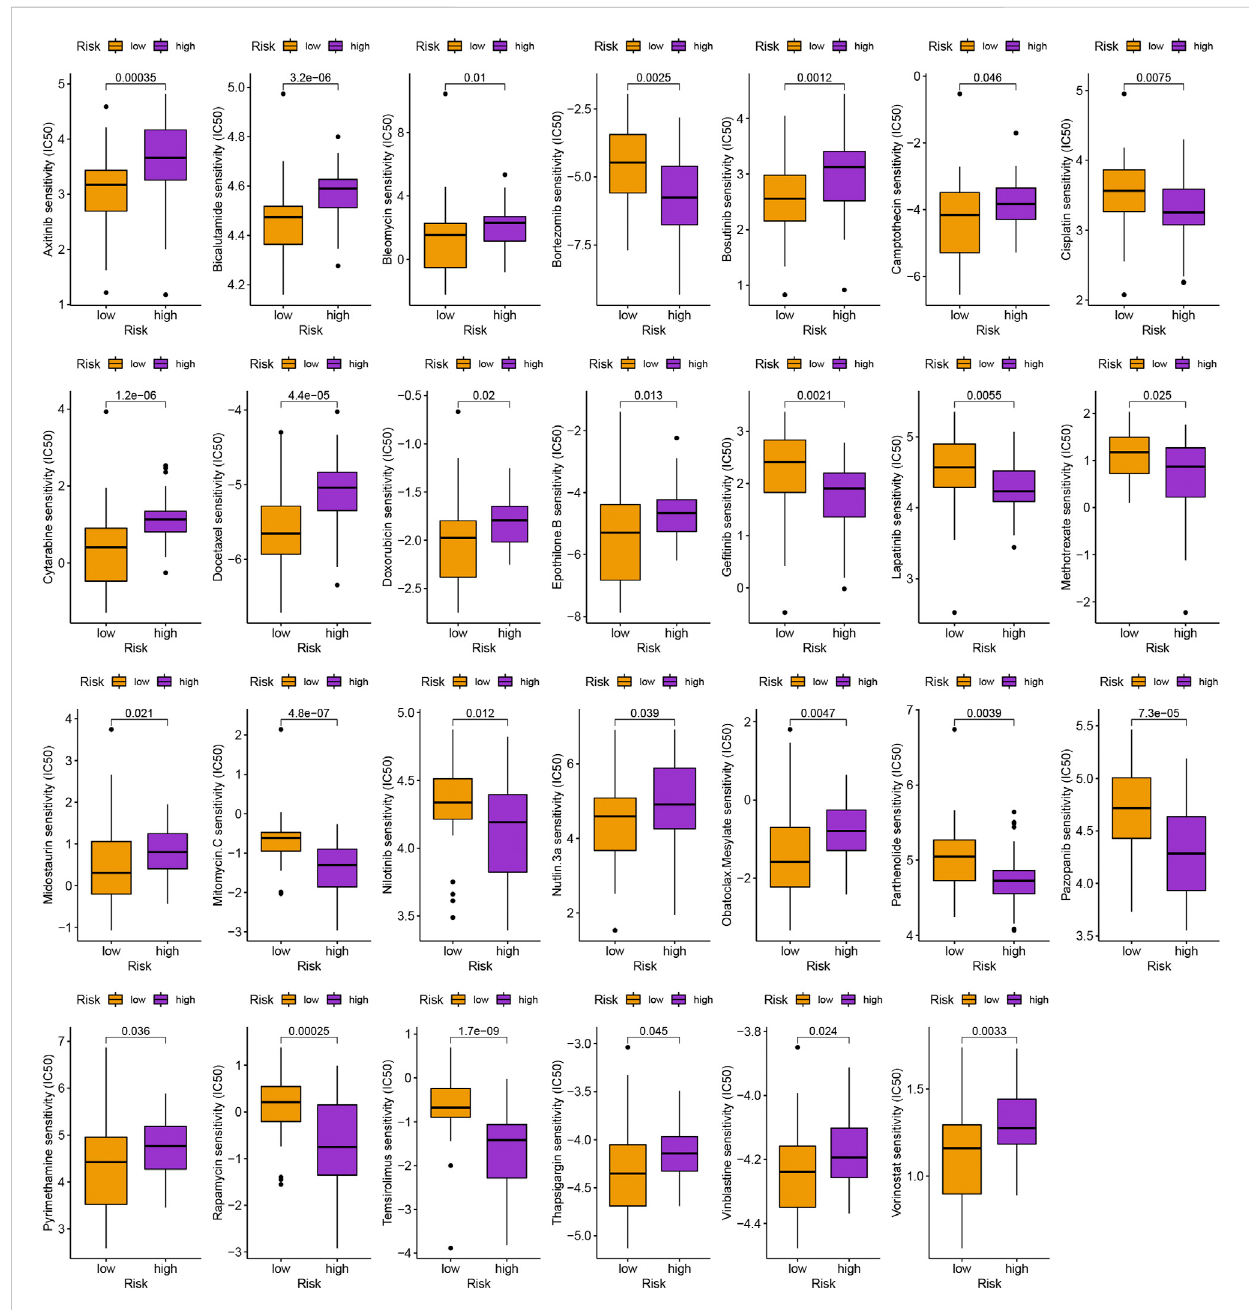
FIGURE 6 Schematic representation of conventional chemotherapy agents for uveal